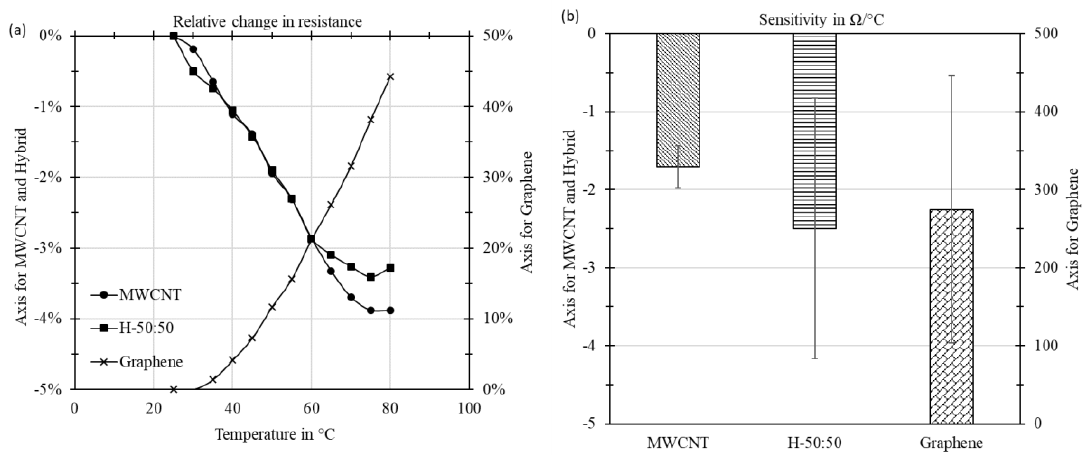
Figure 6. ( a ) Relative change in resistance with temperature for MWCNT, graphene and hybrid (H-50:50) samples and ( b ) sensitivity of the samples to temperature changes.